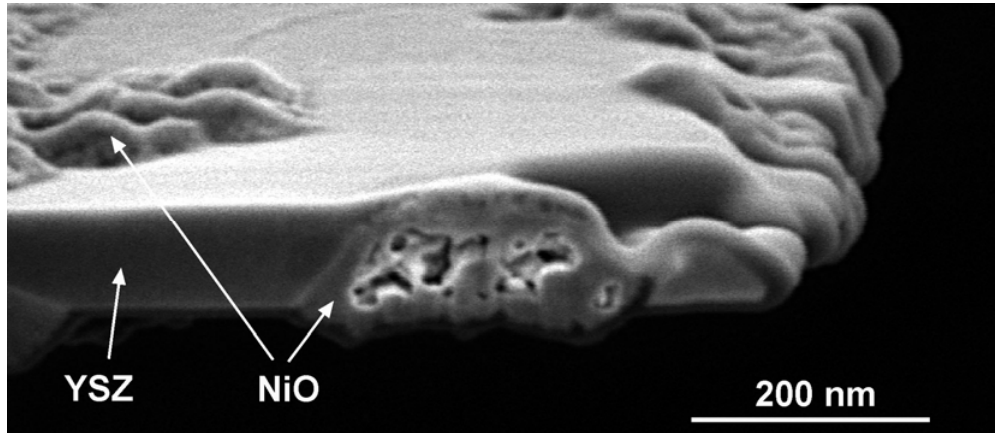
Figure 19. Cross-section of a transmission electron microscope (TEM) lamella after an in situ RedOx cycle, showing the hilly surface and closed porosity of the nickel oxide after reoxidation